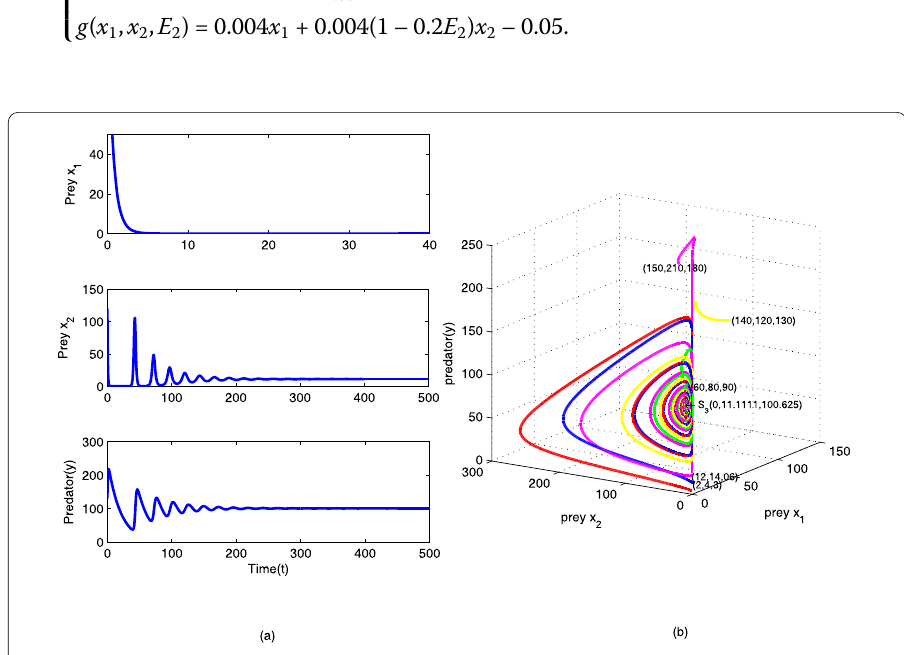
Figure 4 Numerical simulation of model (2.1) around the boundary state S 3 . S 3 (0,11.1111,100.625) with E 1 = 30, E 2 = 25. Different color curves represent different initial conditions. The other parameter values are given in (7.1) and ( k 1 , k 2 ) =